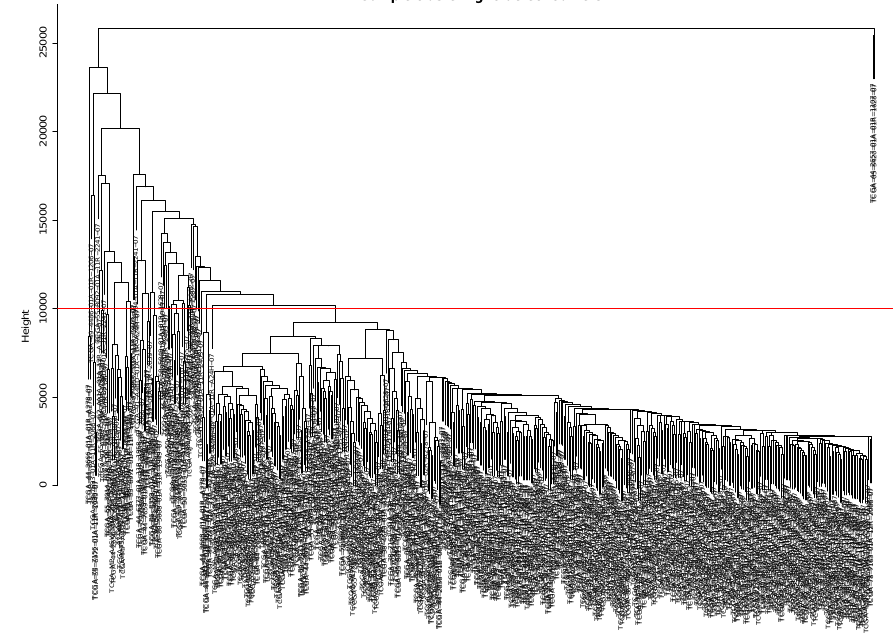
Figure A1. The samples over the red line were considered as the deflection of gene expression, and they were deleted for the outlier elimination.